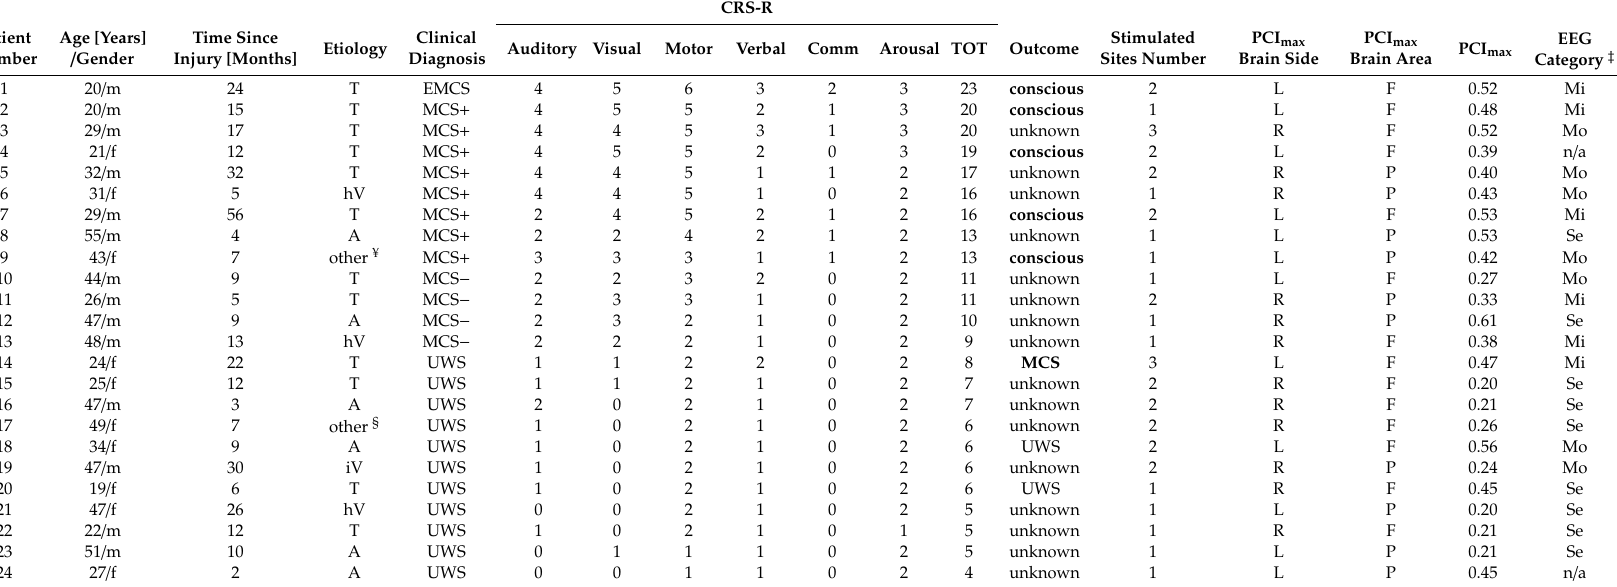
Table 1. Clinical and neurophysiological characteristics of disorders of consciousness (DOC) patients. The Coma Recovery Scale Revised (CRS-R) evaluation corresponds to the best diagnosis out of five assessments (for multiple evaluations with this diagnosis, the one with the highest score is